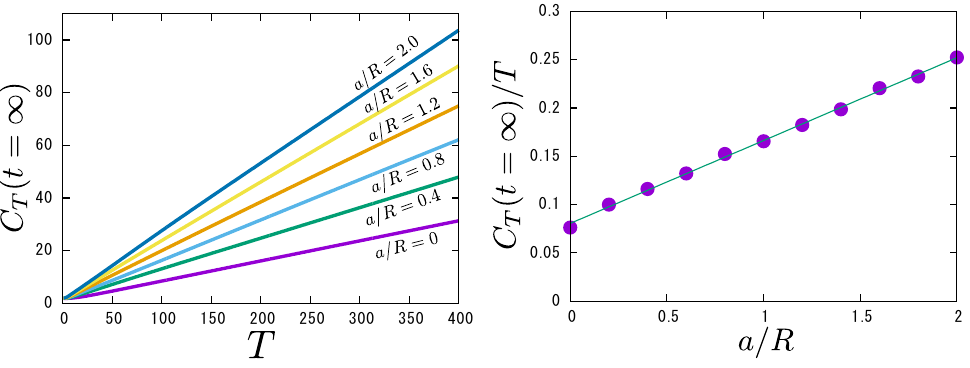
Figure 9 . (Left) Asymptotic values of thermal OTOC as functions of T for several a/R . (Right) Plot of their slopes as function of a/R